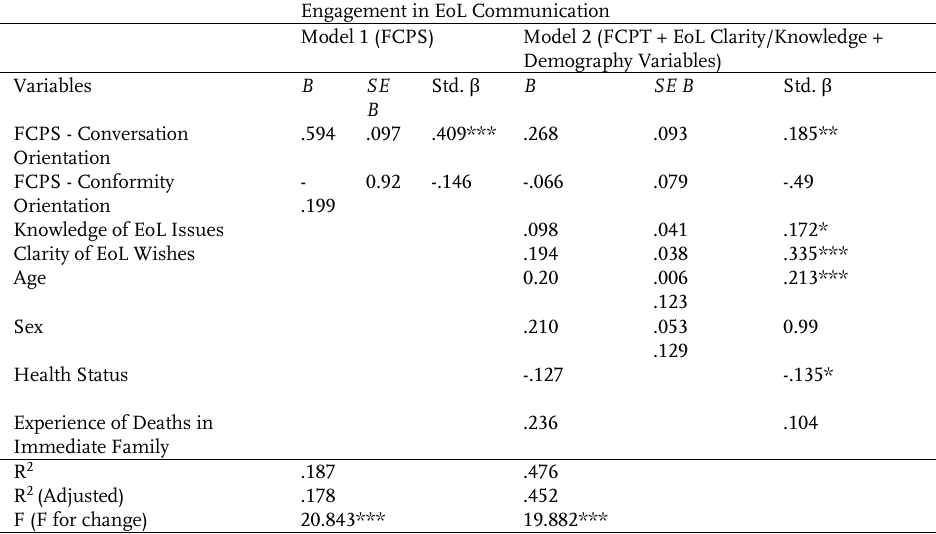
Table 2 : Regression analyses for EoL communication comfort and engagement among middle aged and older individuals